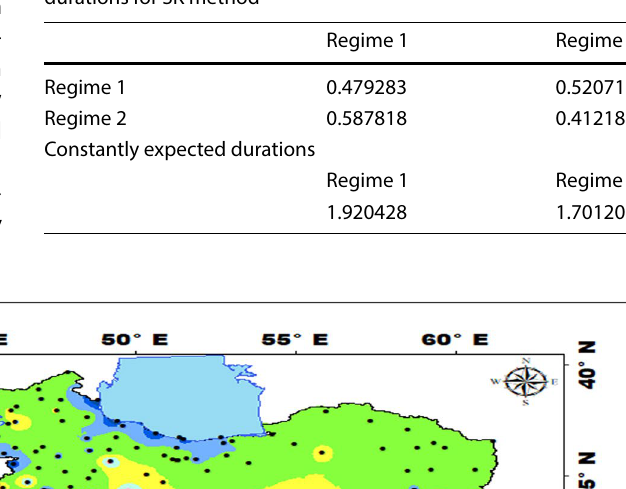
Table 4 Constant Markov transition probabilities and expected durations for SK